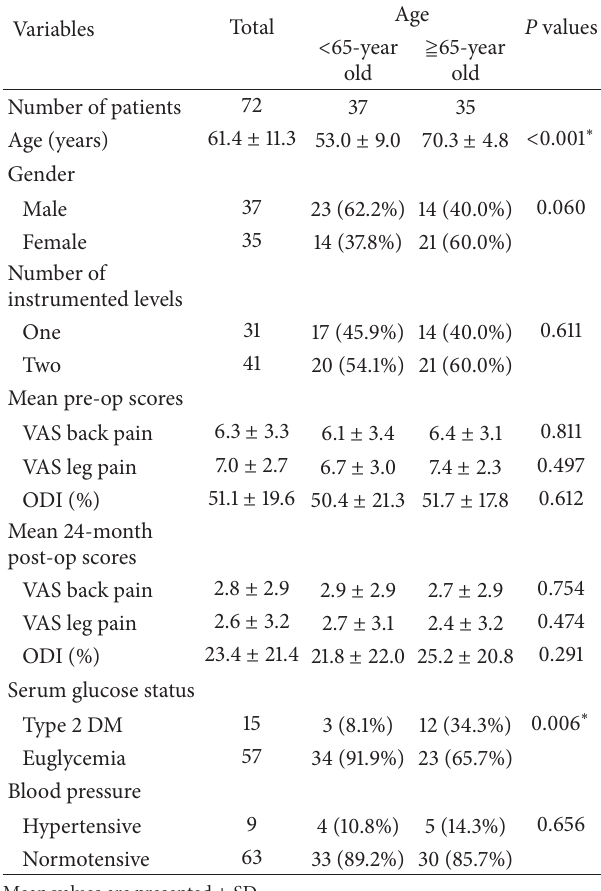
DM: diabetes mellitus. VAS: visual analogue scale. ODI: Oswestry disability